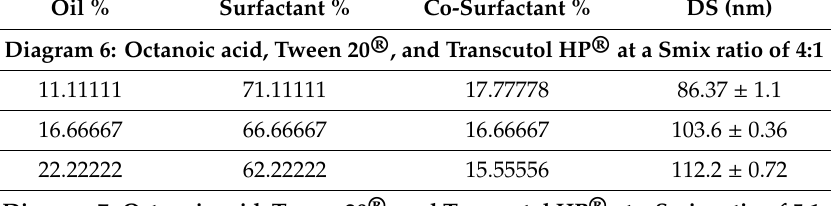
Diagram 7: Octanoic acid, Tween 20 ® , and Transcutol HP ® at a Smix ratio of 5:1.